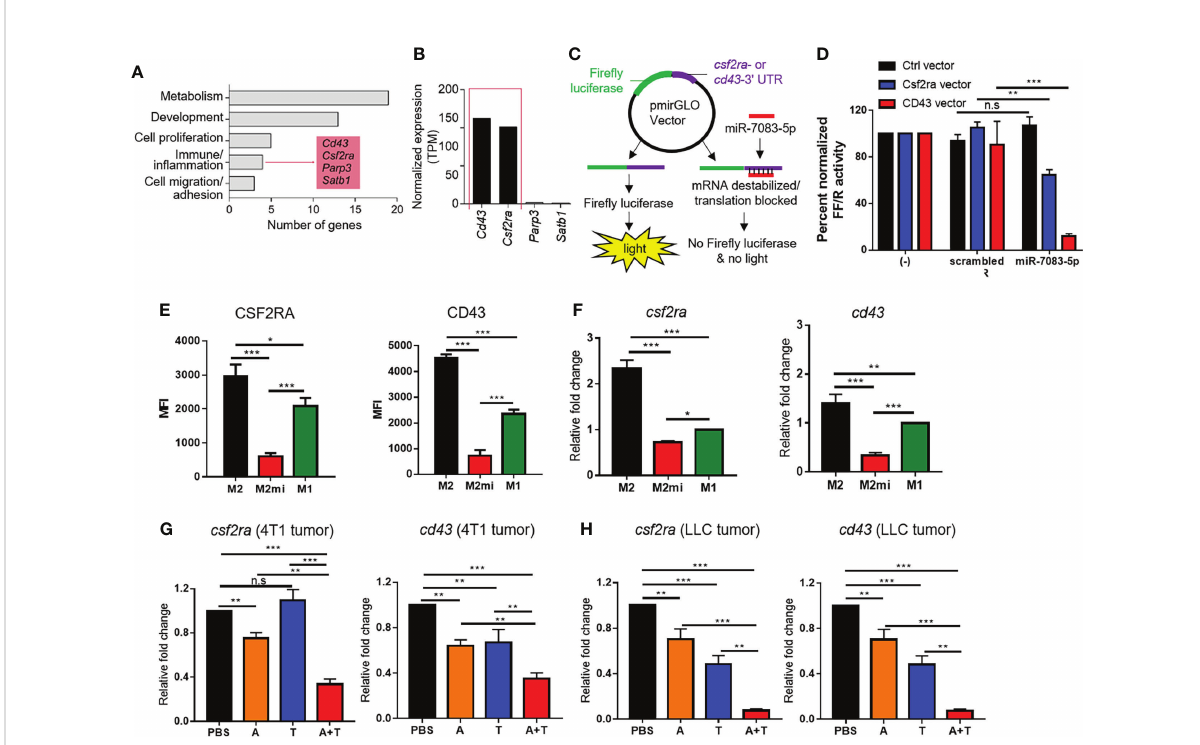
FIGURE 7 CSF2RA and CD43 are downregulated by miR-7083-5p as candidate targets. (A) Functional categorization of 33 predicted targets of miR-7083- 5p. Functional enrichment analysis were performed using DAVID software. (B) Normalized expression levels of the four immune/in fl ammatory response-related genes from the Human Protein Atlas. (C) Experimental schemes of reporter assays using pmirGLO dual-luciferase miRNA target expression vector inserted with CSF2RA- or CD43-3 ′ -UTR and a control (Ctrl) vector. (D) Fire fl y luciferase activity normalized to Renilla luciferase activity (FF/R) of HEK293T cells transfected with the pmirGLO luciferase reporter in the absence or presence of miR-7083-5p or a scrambled control. (E) Flow cytometric analysis of CSF2RA and CD43 expression levels in M2 macrophages (M2) after transfection with miR- 7083-5p (M2mi). M1 macrophages (M1) were used as control. (F) qRT-PCR analysis of relative mRNA levels of csf2ra and cd43 in M2 macrophages after transfection with miR-7083-5p. (G, H) qRT-PCR analysis of the relative mRNA levels of csf2ra and cd43 in 4T1 (G) and